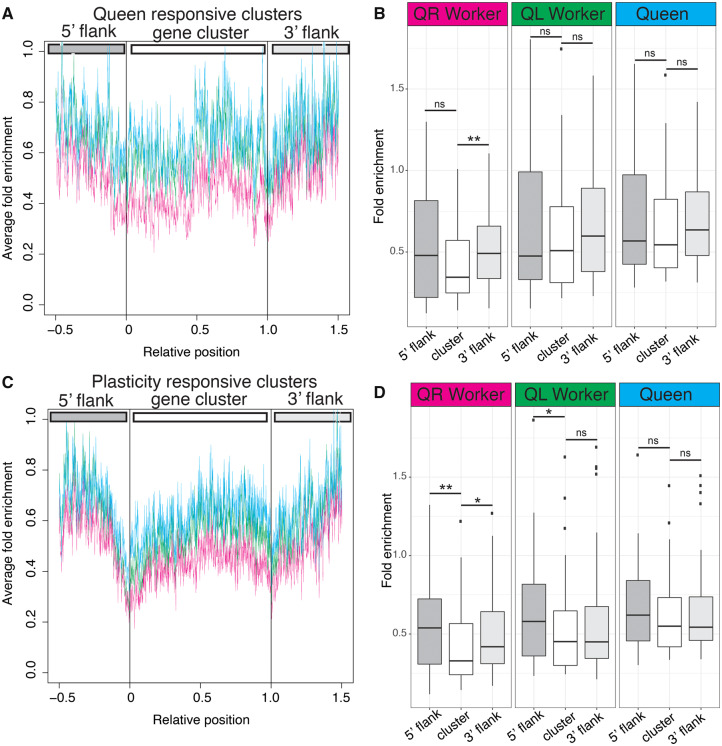
H3K27me3 stably defines “plasticity responsive” gene clusters, prefiguring changes in gene expression. (A) Average H3K27me3 enrichment across gene clusters more highly expressed in queen-right workers (Queen responsive clusters). Cyan is queen H3K27me3 enrichment, green is from queen-less workers, and magenta is from queen-right workers. (B) Boxplot illustrating H3K27me3 enrichment across gene clusters more highly expressed in queen-right workers (Queen responsive clusters). Only the 3′ flank of the clusters is significantly enriched for H3K27me3 in queen-right worker ovaries (Wilcoxon rank sum test, *P < 0.05, **P < 0.01, ns = not significant), showing that H3K27me3 marks are dynamic with respect to the presence of a queen and her pheromone. (C) Average H3K27me3 enrichment across gene clusters more highly expressed in queen-less worker ovaries (Plasticity responsive gene clusters) showing a decrease in H3K27me3 enrichment demarking both the 5′ and 3′ edges of the cluster. (D) Boxplot illustrating H3K27me3 enrichment across gene clusters more highly expressed in queen-less workers (Plasticity responsive clusters). In this case, we see that H3K27me3 marks are relatively stable, with both the 5′ and 3′ flanks of the cluster showing significant enrichment for H3K27me3 relative to the body of the cluster (Wilcoxon rank sum test, *P < 0.05, **P < 0.01, ns = not significant) even though the expression of these genes is low in queen-right workers. Boxplot whiskers indicate minimum and maximum, the box is defined by 25th percentile, median, and 75th percentile. Outliers, data points outside 1.5 times the interquartile range above the upper quartile and below the lower quartile, are shown as individual data points.